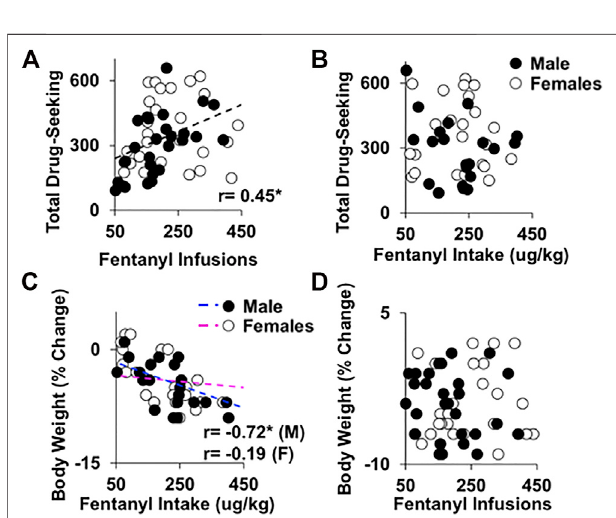
FIGURE6| Associationsbetweenfrequencyoffentanyluseandrelapse vulnerabilityandfentanylintakeandthedevelopmentofphysicaldependence. Frequencyoffentanyluse (A) ,oraveragenumberoffentanylinfusions,butnot amount of fentanyl use (B) , or average fentanyl intake, was positively correlated with relapse vulnerability during extinction and reinstatement testing (total responses) in both males and females ( n = 29 males, n = 29 females). However, amount of fentanyl use (C) , but not frequency of fentanyl use (D) , was signi fi cantly correlated with development of physical dependence, or percent decrease in body weight during early withdrawal in males, but not in females ( n = 29 males, n = 29 females). r, Pearson correlation, (*) signi fi cant